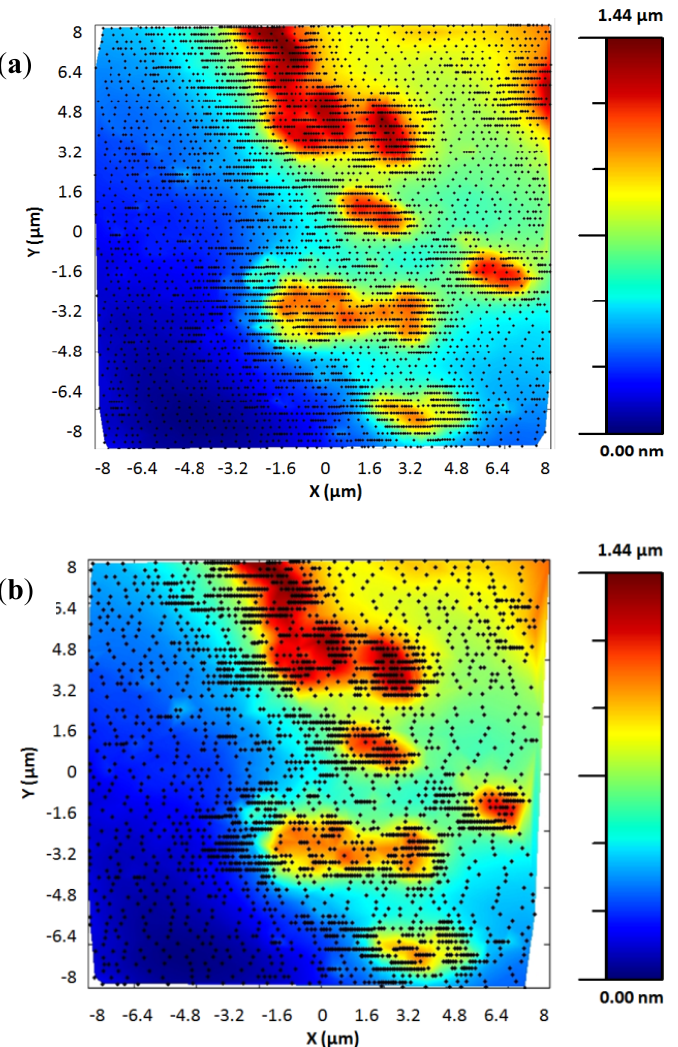
Figure 11. Tune of the different parameters. ( a ) γ = 8, v = 16 µm/s, imaging time = 2 min max 23 s. ( b ) γ = 8, v = 32 µm/s , imaging time = 1 min 21 s. ( c ) γ = 6, v = 32 µm/s, max max = 32 µm/s, imaging time = 1 min 6 s. ( e ) γ = 5, imaging time = 1 min 11 s. ( d ) γ = 5, v max v = 48 µm/s, imaging time = 45 s. ( f ) γ = 5, v = 64 µm/s imaging time = 34 max max